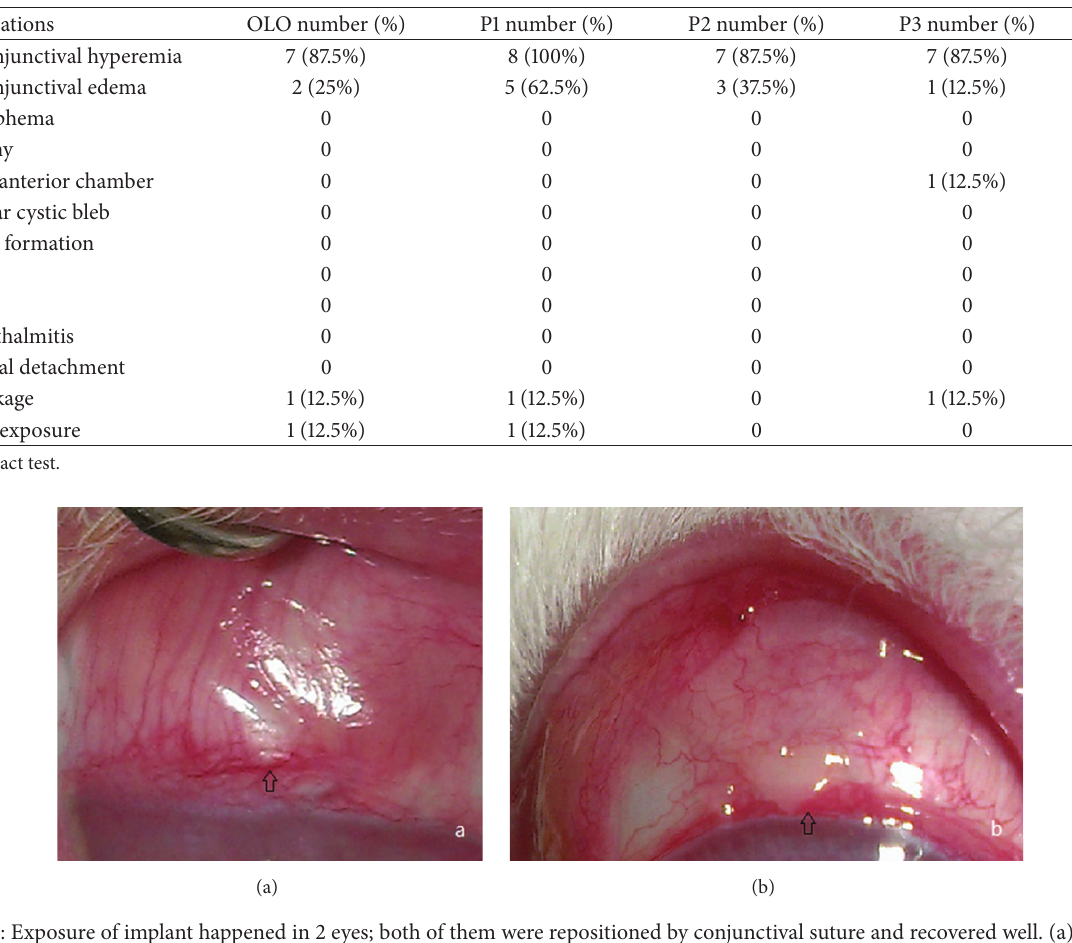
group P3 and 2 eyes of the OLO group even after